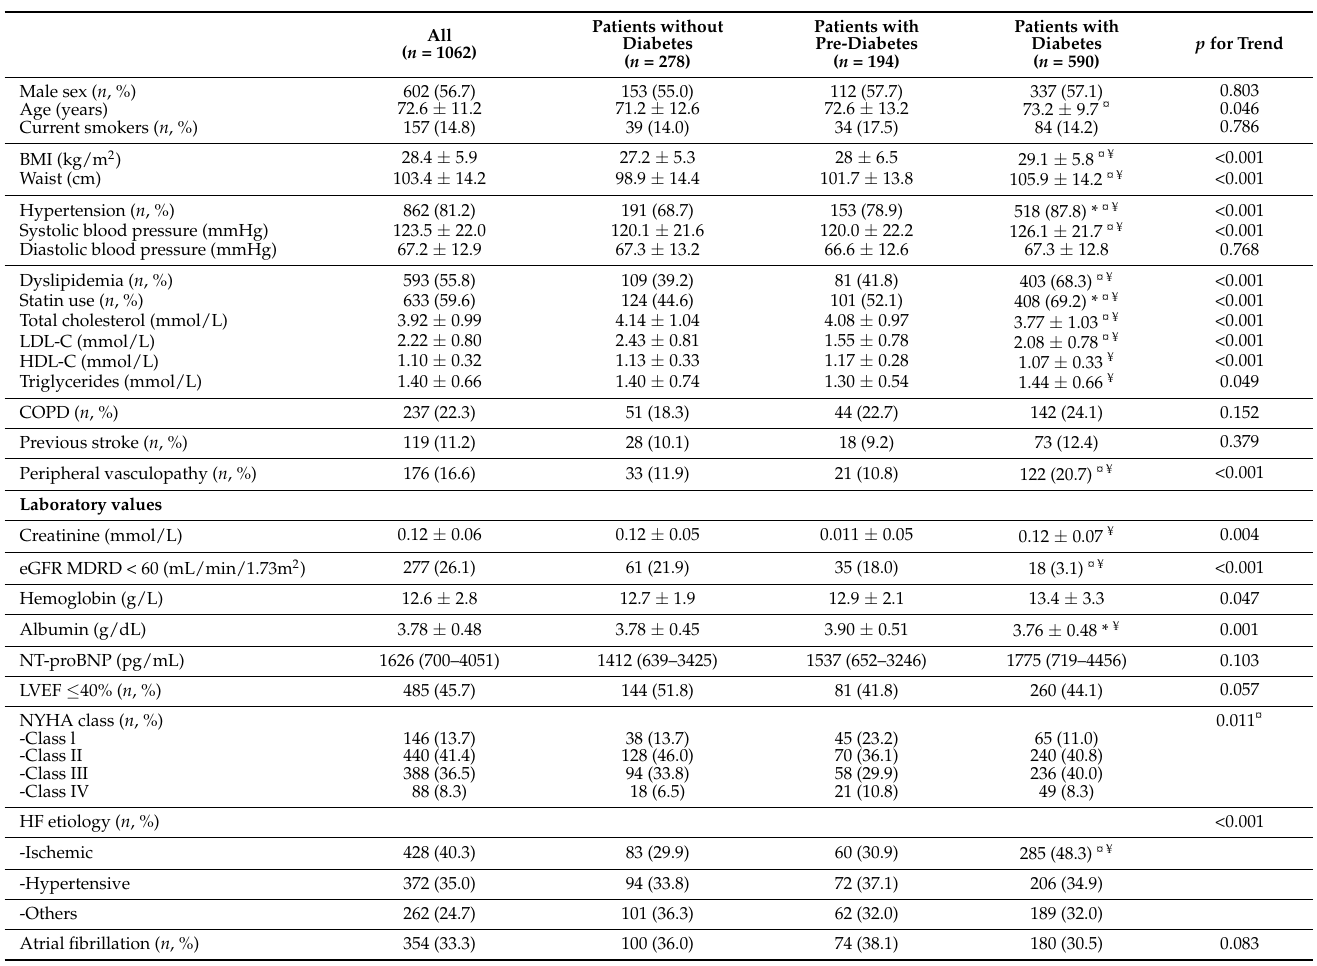
The baseline clinical characteristics of the subjects included in the study are shown in Table 1. Subjects with diabetes were older and had higher prevalence of arterial hyperten- sion, dyslipidemia, and peripheral artery disease compared with those without diabetes. They also had higher weight, BMI, waist circumference, higher levels of systolic blood pressure, higher concentrations of triglycerides, creatinine, and NT-proBNP, but lower levels of total-, LDL-, and HDL-cholesterol (in the context of higher percentage of subjects under lipid-lowering treatments) and hemoglobin. Moreover, subjects with diabetes had a higher prevalence of chronic kidney disease, heart failure of ischemic etiology, and NYHA class III–IV. There were no differences between groups for gender distribution, smoking habit, and percentage of subjects with LVEF ≤ 40 %. The use of angiotensin-converting enzyme inhibitors was lower in subjects with diabetes, while the use of angiotensin receptor blockers, aldosterone antagonists, diuretics, and amiodarone was similar in both groups. Statin, nitrates, and antiplatelet drugs were used more commonly in subjects with diabetes mellitus. Subjects with diabetes had higher ratios of acute heart failure hospitalization during the last year. Table 1. Baseline characteristics of the whole cohort of patients with acute heart failure stratified by diabetes status. Patients without Patients with Patients with All p for Diabetes Pre-Diabetes Diabetes ( n = 1062) ( n = 278) ( n = 194) ( n = 590)